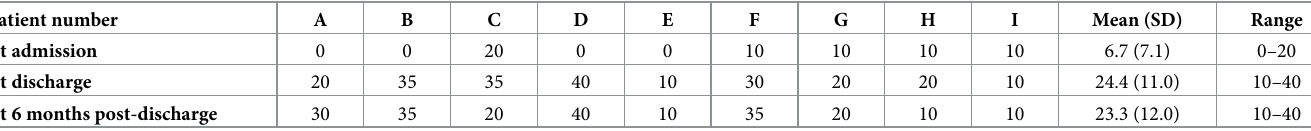
Table 3. Results of the Japanese Orthopaedic Association hip score for pain in nine patients